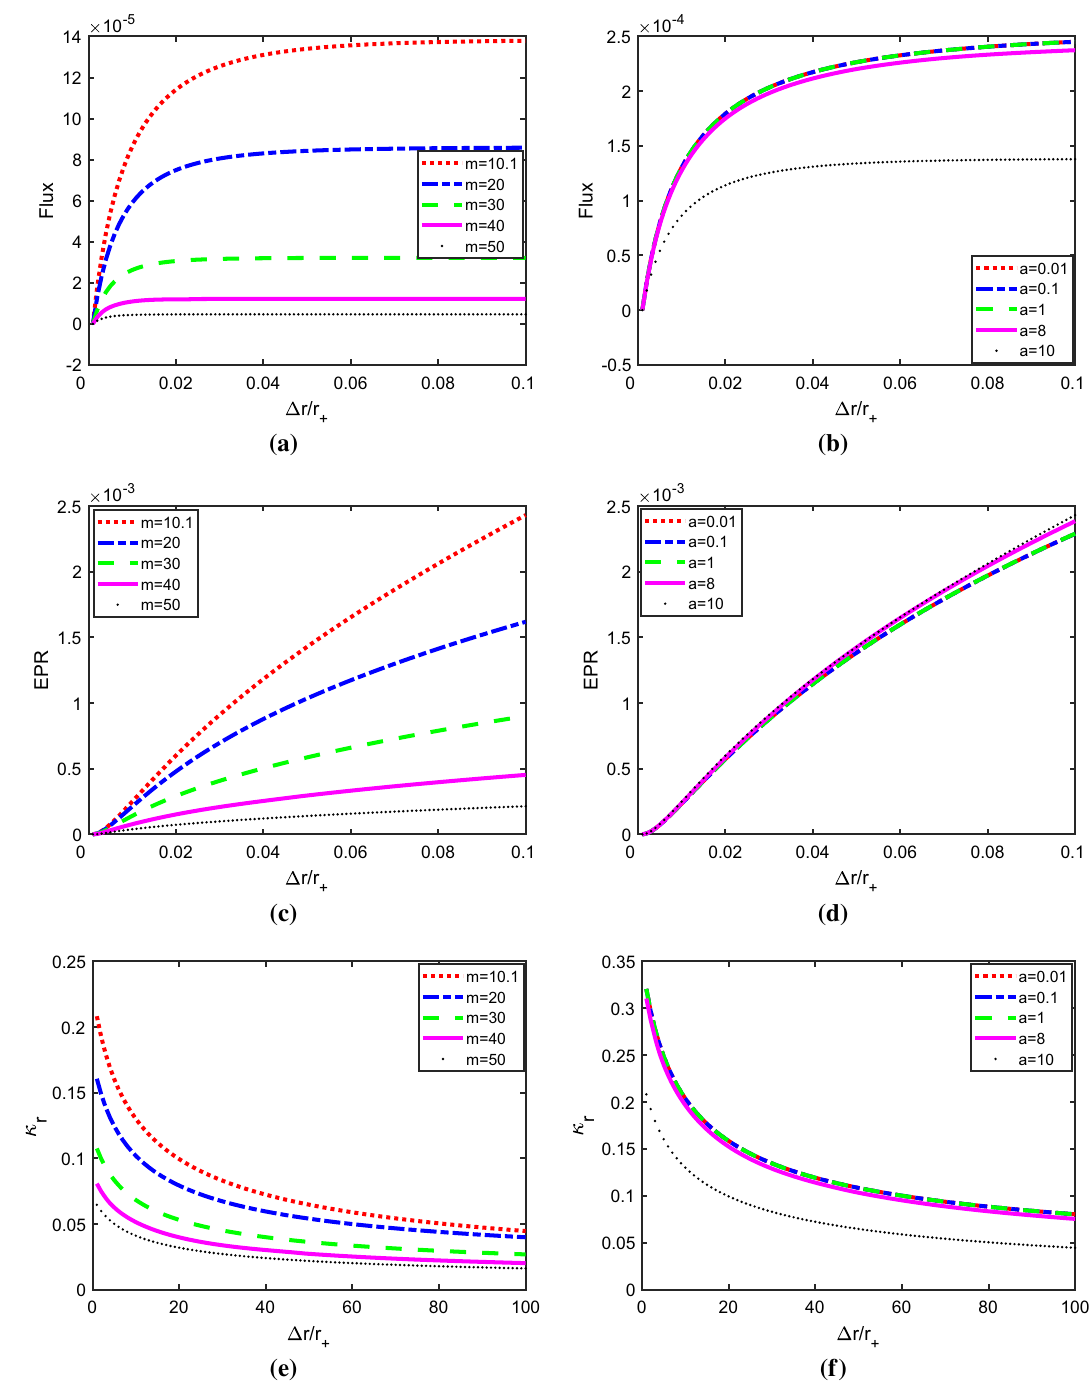
Fig. 14 The a , b flux and c , d EPR at nonequilibrium steady state vary with separation distance for a = 10 or M = 10. e , f The κ r varies with separation distance for a = 10 or M = 10. One of the two atoms is stationary at 1 . 006 r + , while another is at ( 1 . 006 + (cid:2) r ) r